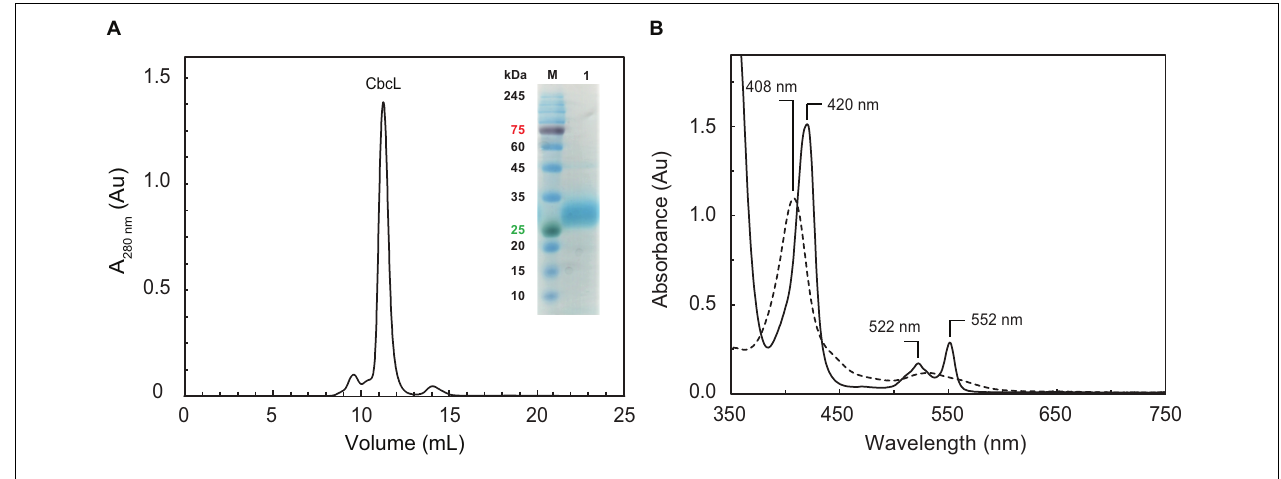
FIGURE 1 | Purification of cytochrome CbcL and its UV-visible spectral features. (A) Size exclusion chromatography elution profile for the last step of CbcL purification. The inset shows an SDS-PAGE gel for purified CbcL (lane 1) and molecular weight marker (lane M). (B) UV-visible spectra of CbcL (1 µ M in 10 mM phosphate buffer pH 8) at room temperature. The solid and dashed lines correspond to the reduced and oxidized state (as purified), respectively.